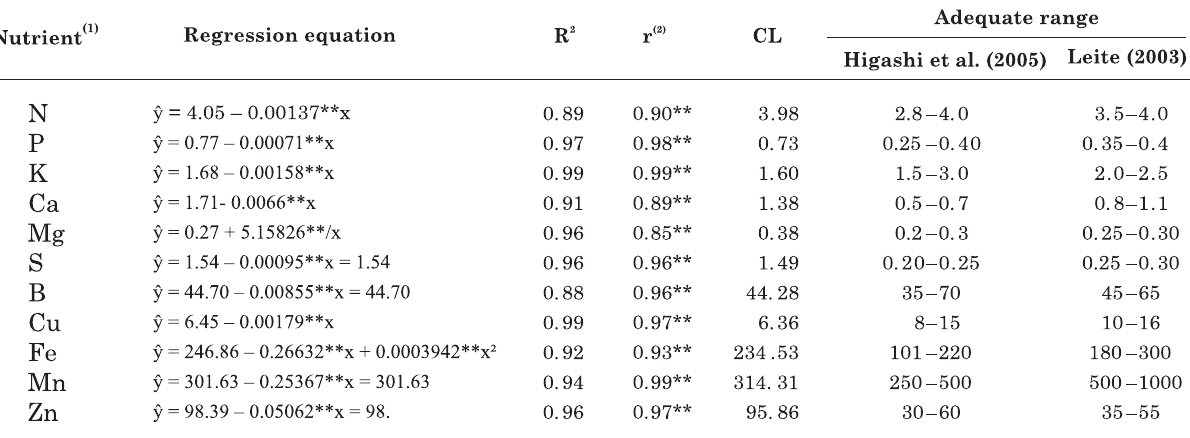
Table 2. Regression equation adjusted to macro and micronutrient contents, simple correlation coefficients (r), of nutrient critical levels (CL) in function of N rates in nutrient solution, during 30 days of